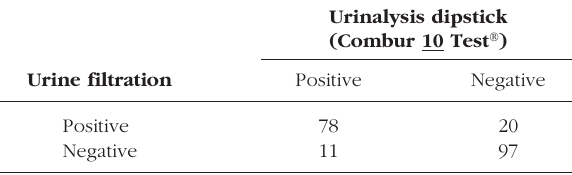
Table I. – Diagnostic performance of Urinalysis dipstick (Combur 10 Test ® ) compared with urine filtration for the diagnosis of S. hae- matobium in Hassoba Elementary school, Afar,